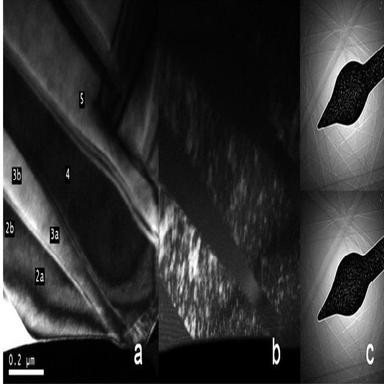
Structures in a PLZT 4:90:10 sample: (a) Strong beam dark field image of the domain structure; (b) weaker beam image of the nanostructure in domains 2 and 4; (c) processed Kikuchi pattern from point 3a.